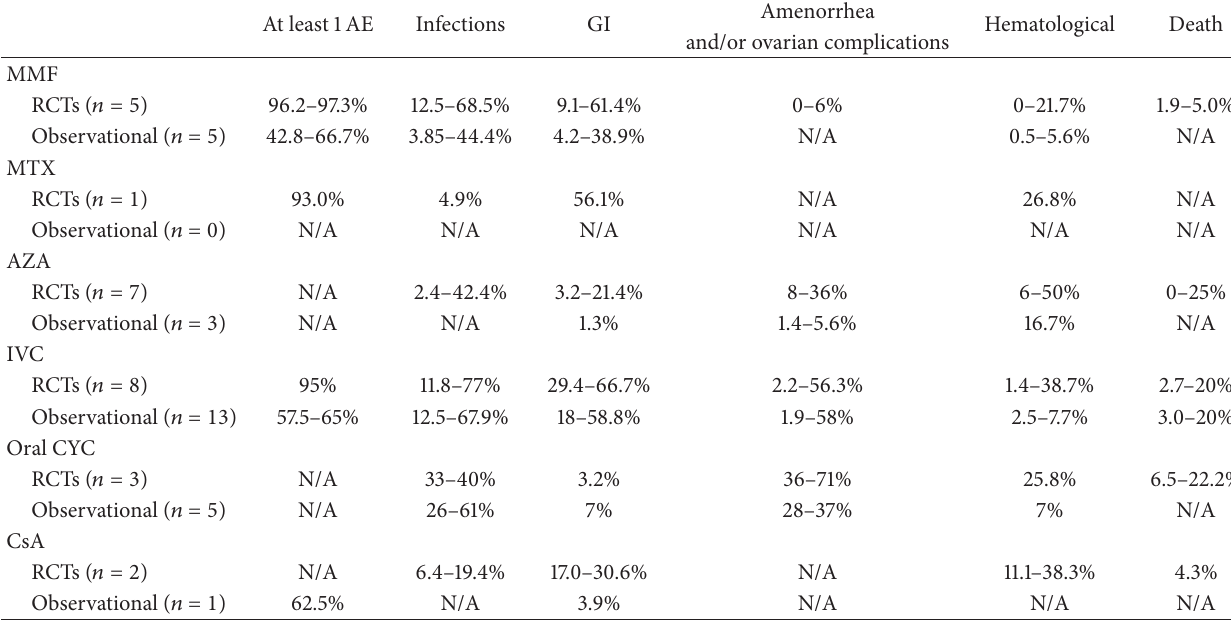
Table 1: Summary of commonly reported AEs by